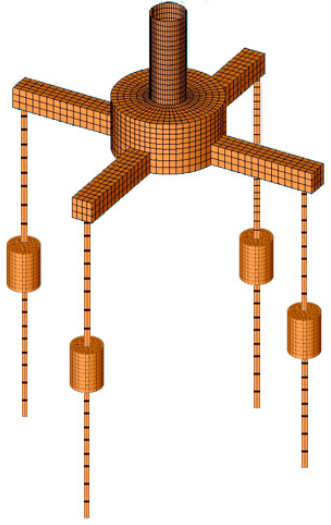
Figure 5. Panel model of Serbuoys-TLP system for the hydrodynamic analysis.